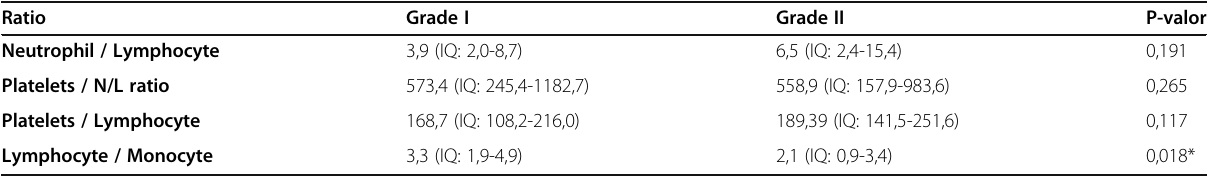
Table 3 Median and interquartile range in relation to tumor